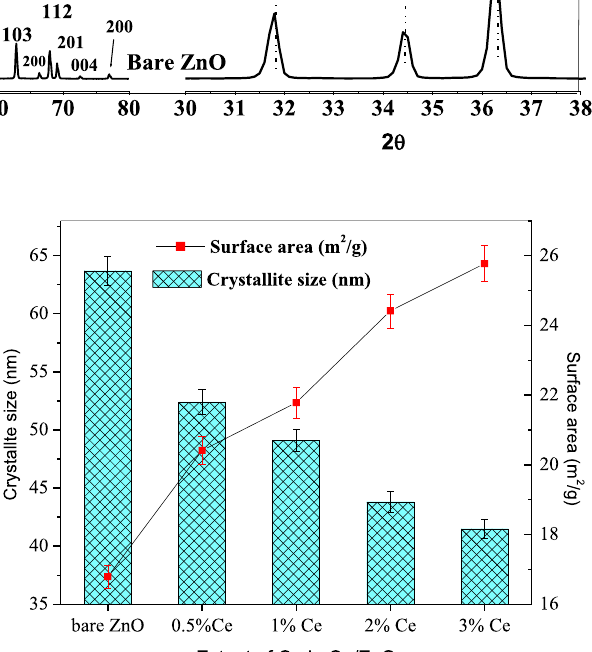
Fig. 4 Crystallite size (nm) and specific surface area (m 2 /g) of Ce/ ZnO and bare